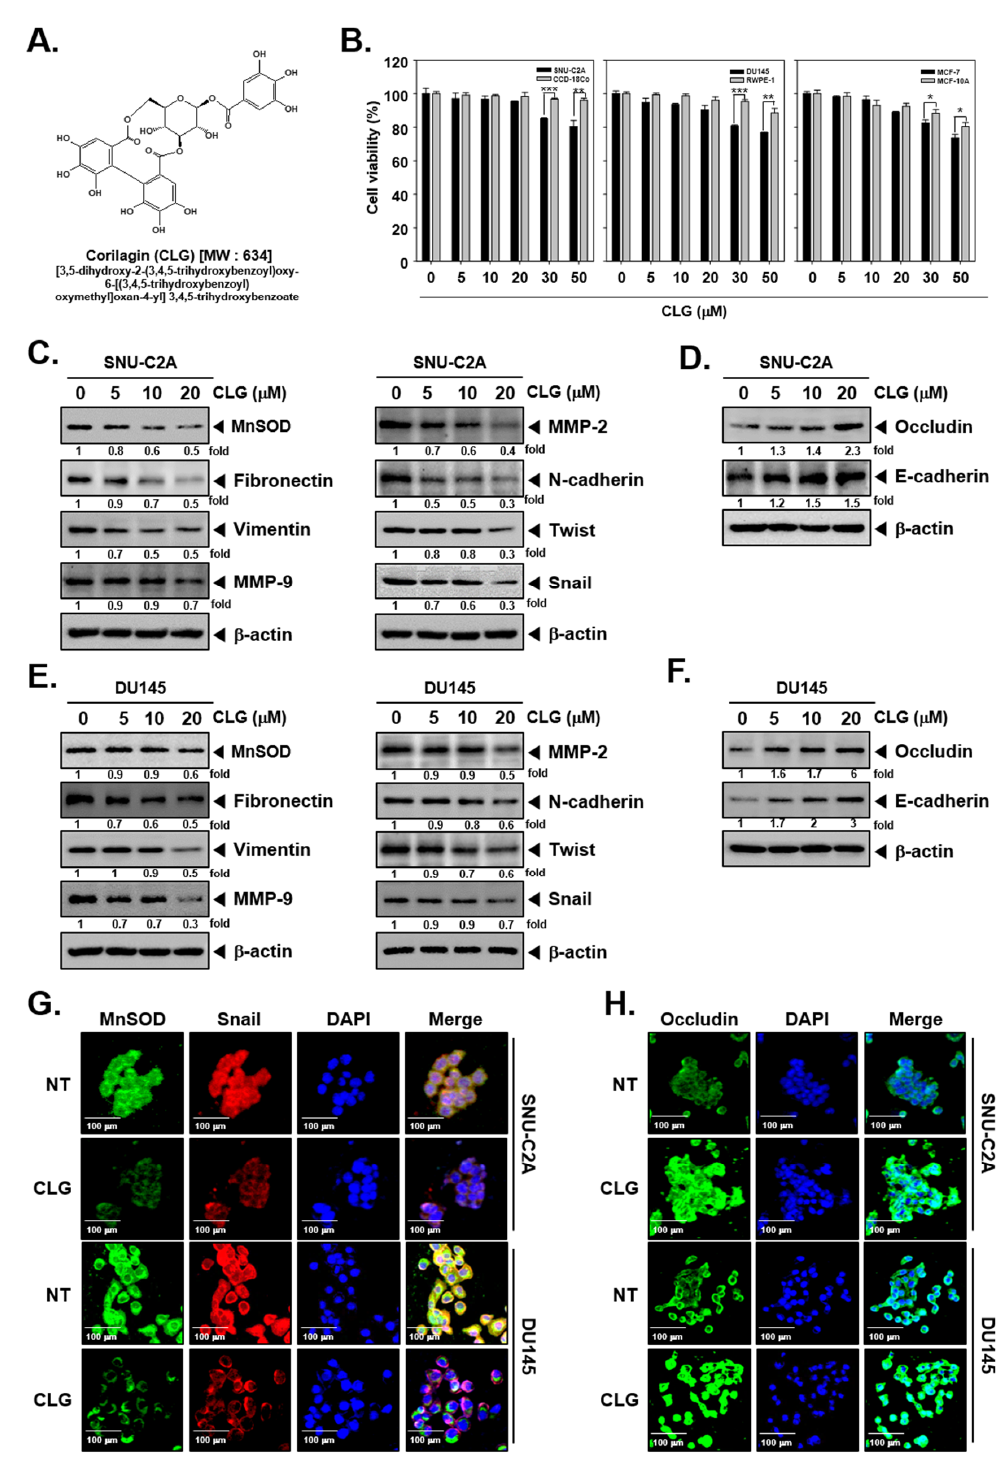
Figure 1. Corilagin (CLG) inhibits epithelial-mesenchymal transition (EMT) in SNU-C2A and DU145 cells. ( A ) The structure of corilagin (CLG). ( B ) Cell viability was measured by MTT assay with CLG (0, 5, 10, 20, 30, 50 µ M) for 24 h. Data represent means ± SD. * p < 0.05 vs cancer cells, ** p < 0.01 vs cancer cells, *** p < 0.001 vs cancer cells. ( C – F ) SNU-C2A and DU145 cells were exposed to CLG for 24 h. Whole cell lysate were extracted levels of various proteins was evaluated by Western blot analysis. ( G ) and ( H ) Expression of MnSOD, Snail, and Occludin was measured by immunocytochemistry in SNU-C2A and DU145 cells.